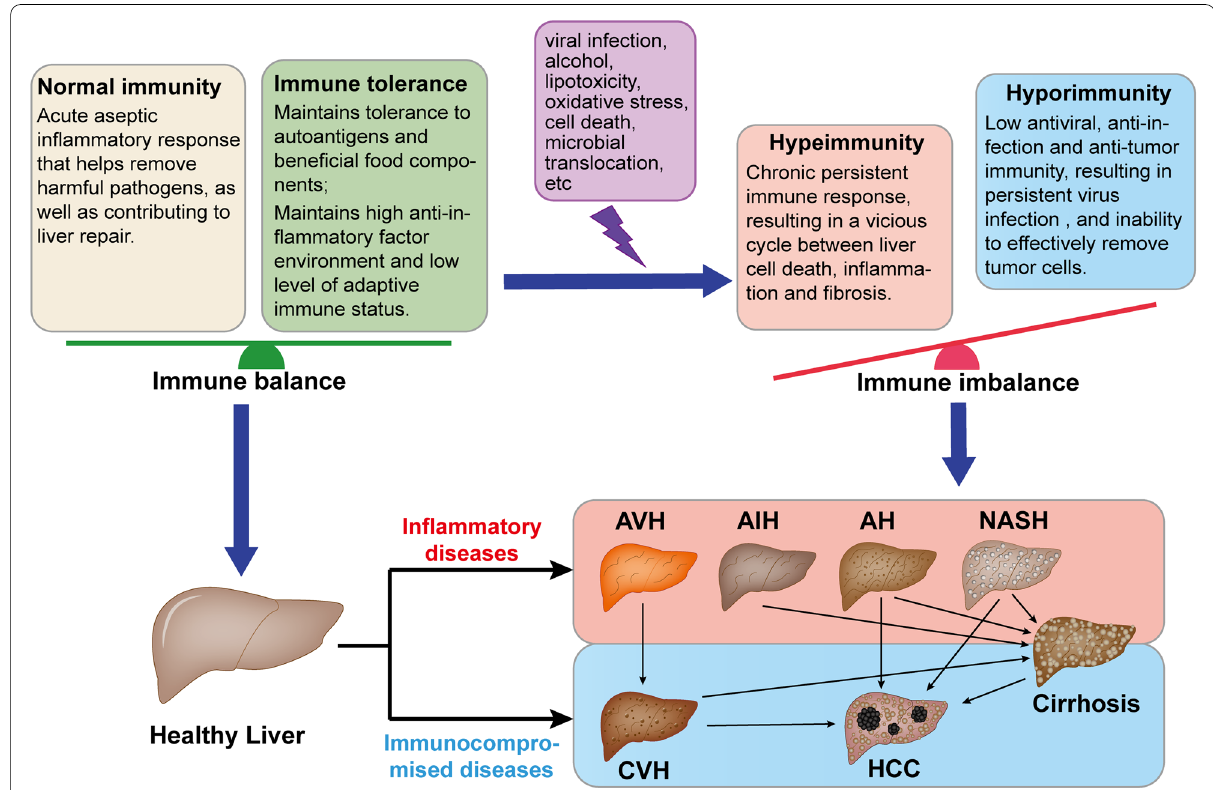
Fig. 2 The relationship between imbalance in the hepatic immune microenvironment and liver diseases. Normal hepatic immunity and immune tolerance together maintain the balance of the immune microenvironment. The immune microenvironment is disrupted under the stimulation of multiple external factors. On the one hand, excessive immune activation leads to the development and progression of inflammatory liver diseases, including AIH, AVH, AH, NASH, and cirrhosis. Among them, cirrhosis is characterized by the coexistence of inflammation and immune deficiency. On the other hand, low antiviral and antitumor immunity leads to the development and progression of immunocompromised liver diseases, including CVH and HCC. Without effective treatment, these chronic liver diseases will gradually develop into cirrhosis and then transition to HCC, or can develop directly into